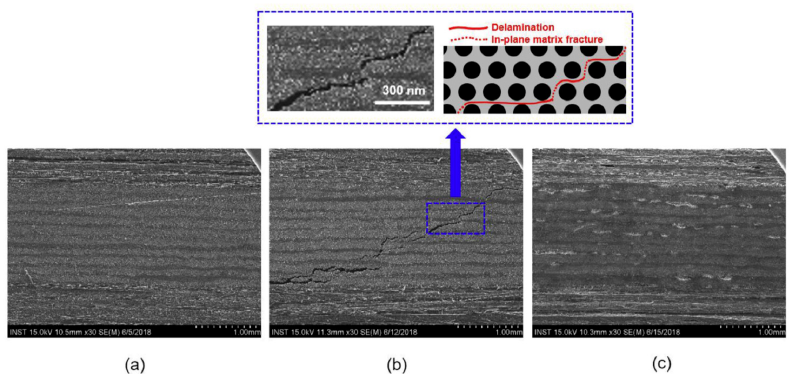
Figure 14. Cross sectional SEM images of carbon fiber reinforced polypropylene (CFPP) mixed with CNTs: ( a ) initial, ( b ) damaged, and ( c ) self-healed samples [110]. Reproduced with permission from Joo, S.J; Composites Science and Technology; published by Elsevier, 2018. Chen et al. reported a self-healing composite by Joule effect produced by the coating of paraffin with PET films containing AgNWs. The sheet resistance of the composite was